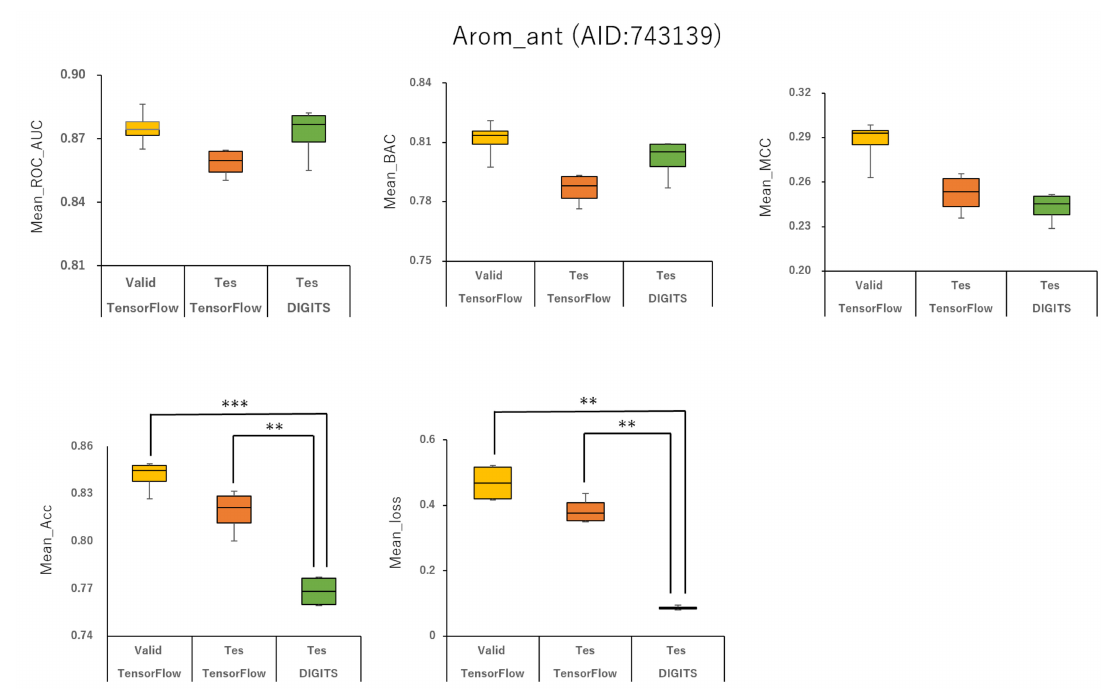
Figure 8. Means ROC_AUC, means BAC, means MCC, means Acc, and means loss of Arom_ant (AID:743139) in validation and test datasets in TensorFlow and test dataset in DIGITS. ** p < 0.01, *** p < 0.001 for t -test.